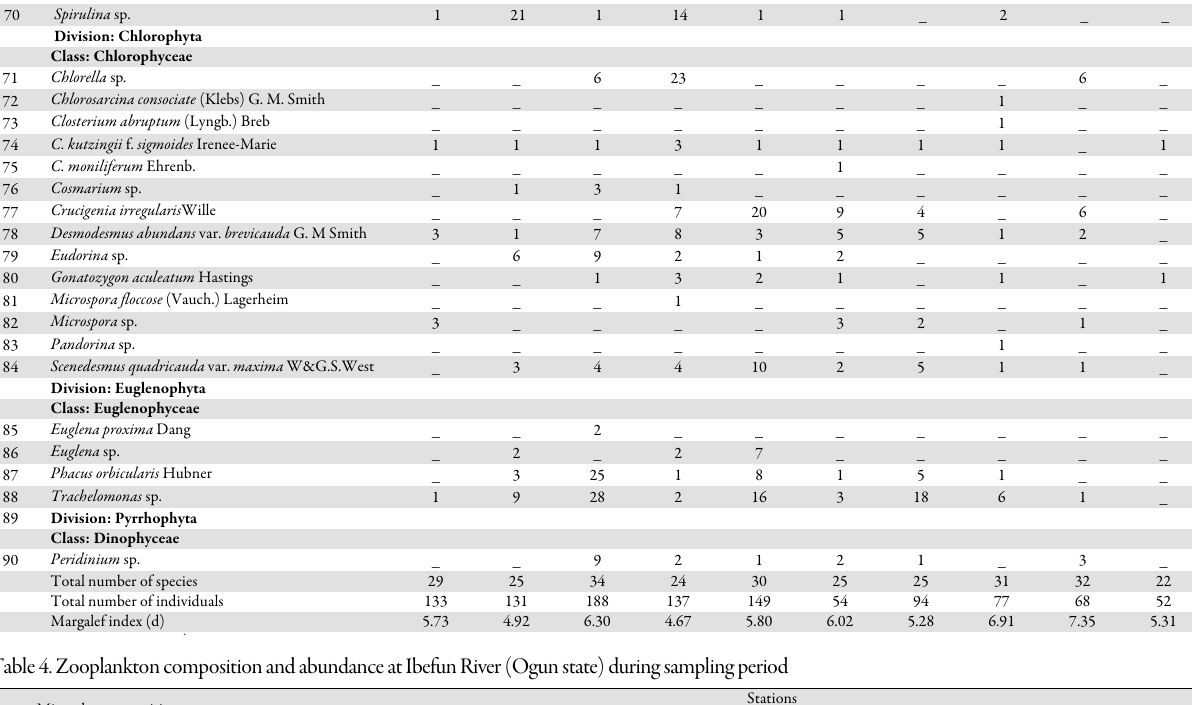
Brachionus sp. Gastropus sp. Brachyuran sp. Copilia sp. Euchirella sp. Scolecithrix sp.